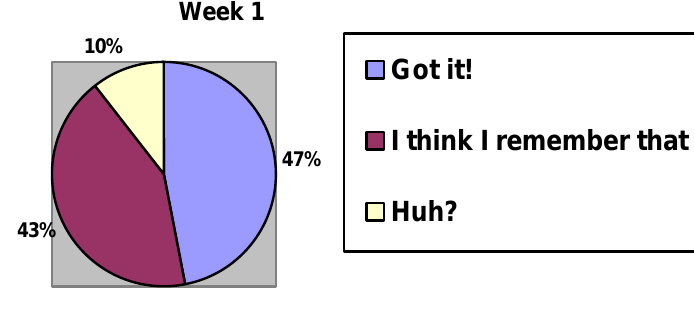
Figure 9. Student Comprehension Checklist for week one compiled prior to the implementation of posting and communicating daily learning